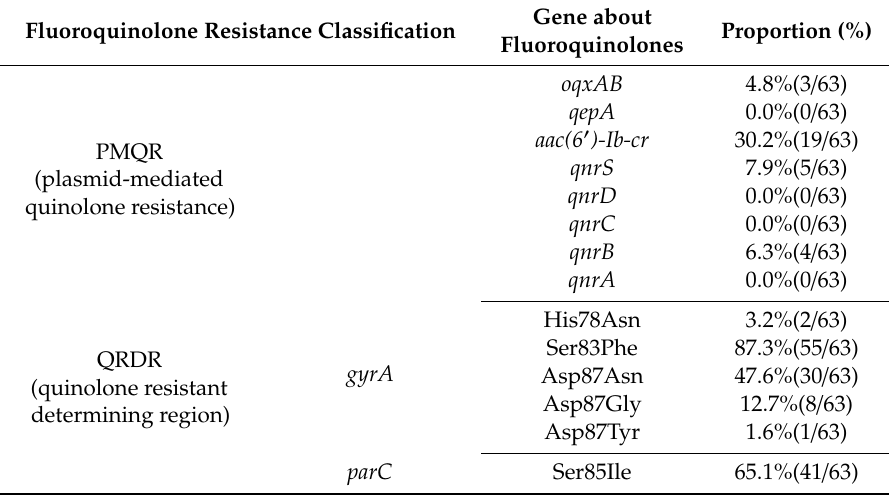
Table 1. Drug resistance genes detected in strains of Salmonella Kentucky ST198.